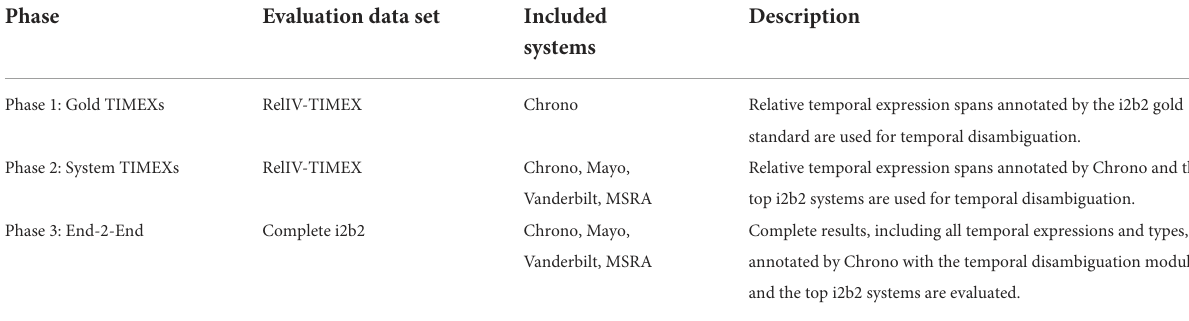
TABLE 3 Evaluation phases for classification